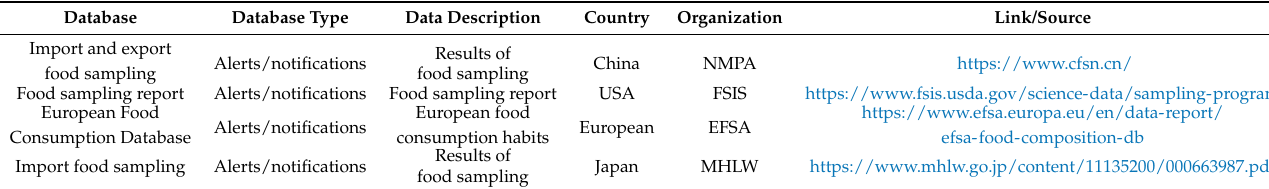
Table 1. The public regulatory